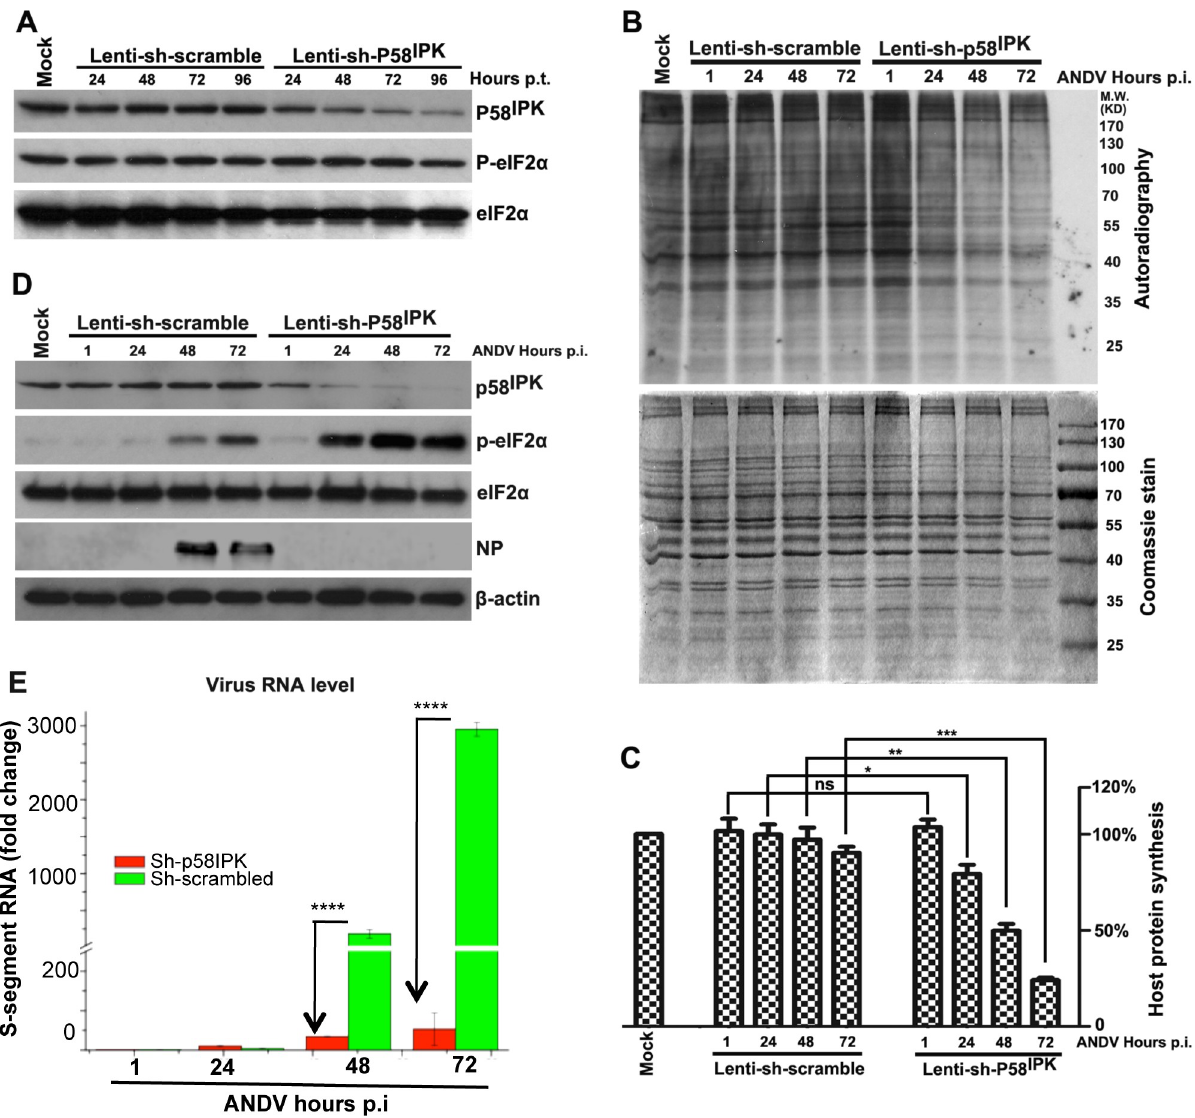
Fig 7. The knockdown of P58 IPK induces translational shutoff and restricts Andes virus replication in cells. A. HUVECs were transduced with lentivirus at an MOI of 3, expressing either scrambled shRNA or shRNA targeted against P58 IPK . Cells were harvested at different time points post- transduction and the cell lysates were examined by western blot analysis using appropriate antibodies. B. HUVECs were transduced with lentivirus as mentioned in panel A. Cells were infected with Andes virus at an MOI of 0.5, 24 hours post lentivirus transduction. Cells were metabolic labeled with 35 S methionine-cysteine for 40 min. before harvesting at different time points post Andes virus infection. Cell lysate were separated by SDS-PAGE and visualized by Coomassie blue stain (bottom). The same Coomassie stained gel was dried and exposed to X-ray film (top). C. The band intensities from the autoradiogram were quantified by Image-Pro plus software and normalized to that of the mock control. Results from two independent experiments were used to calculate standard deviations, shown as error bars. The significance ( � ) was calculated by the students t test. D. The cell lysate from panel B was examined by western blot analysis using appropriate antibodies. E. HUVECs were transduced with lentivirus followed by Andes virus infection as mentioned in panel B. Total RNA was purified from cell lysates and viral S-segment RNA levels were quantified in each sample by real time PCR as mentioned in Materials and Methods section. Fold changes in viral RNA levels related to 1.0 hour time point in each group are shown. Results from three independent experiments were used to calculate standard deviations, shown as error bars. The significance in fold change ( � ) was calculated by the students t